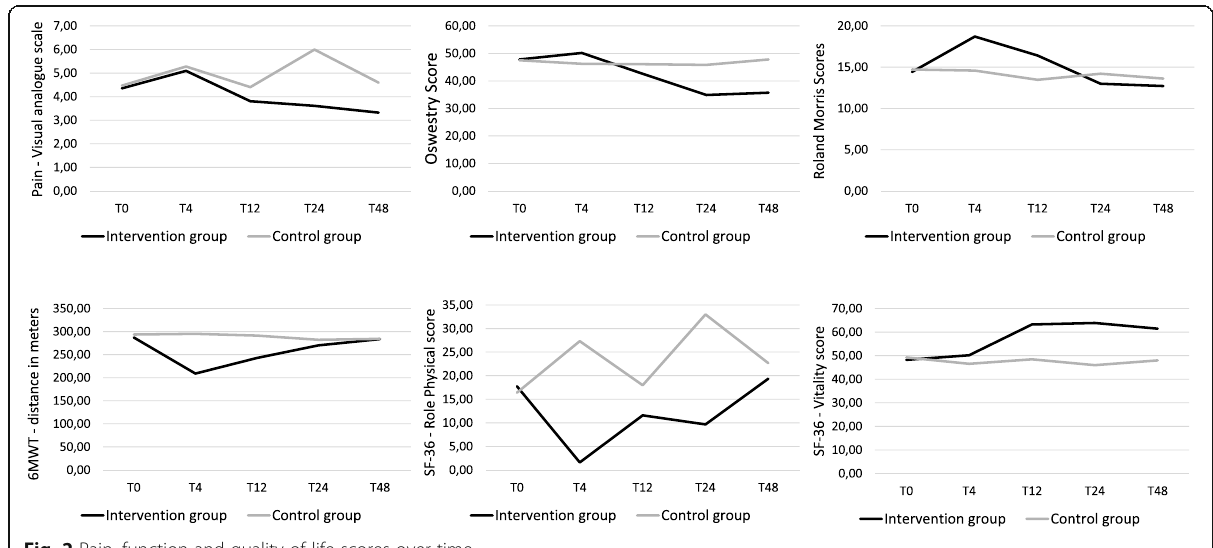
Fig. 2 Pain, function and quality of life scores over time